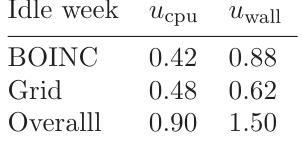
Table 5. CPU Utilization of BEIJING site during a busy and an idle week Busy week